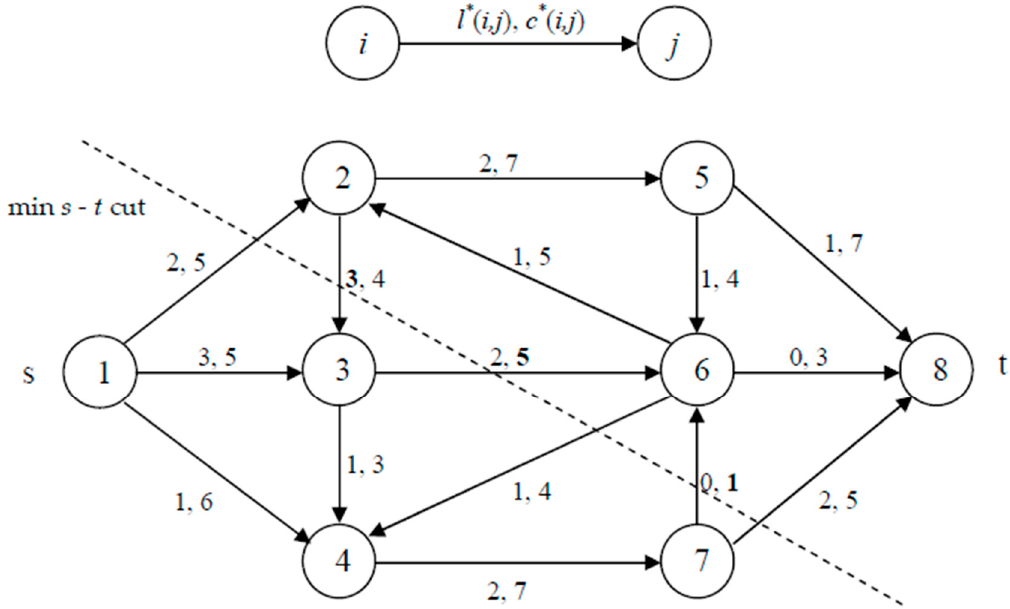
Figure 3. Optimum solution of inverse minimum cut problem with lower and upper bounds 1 (IMCUL1).